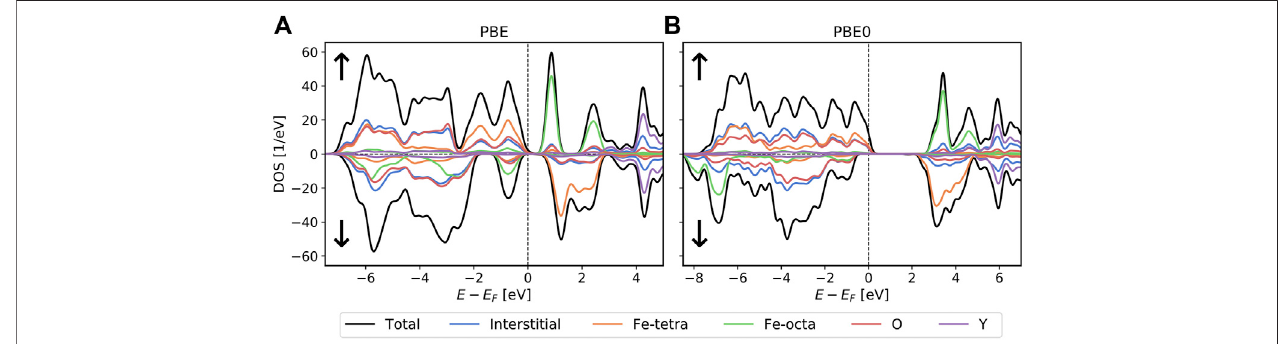
FIGURE 7 | DOS of YIG calculated with PBE in (A) and with PBE0 in (B) on a 2 × 2 × 2 k -grid. In both calculations we use a K max (cid:2) 4 . 5 a 0 − 1 . The mixed-product basis for the calculation in (B) uses a eigenvalue threshold of ] = 10 − 4 and an l MPB = 16 cutoff for the spherical harmonics.